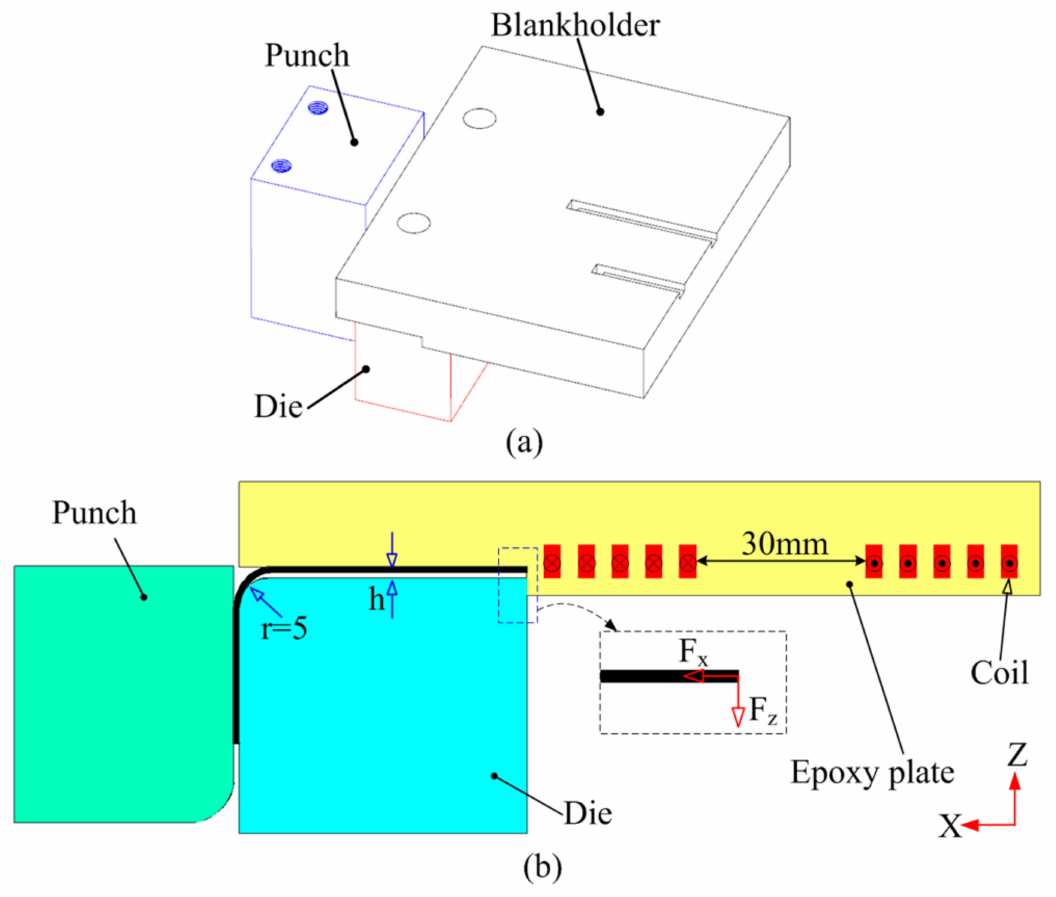
Figure 3. Forming system: ( a ) schematic diagram of 3D metal sheet forming device, ( b ) 2D forming